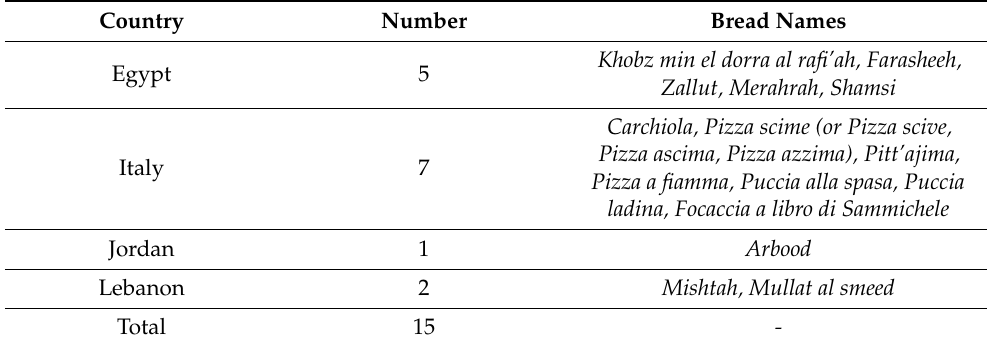
Table 13. Breads surveyed by Slow Food Foundation for Biodiversity as “Ark of